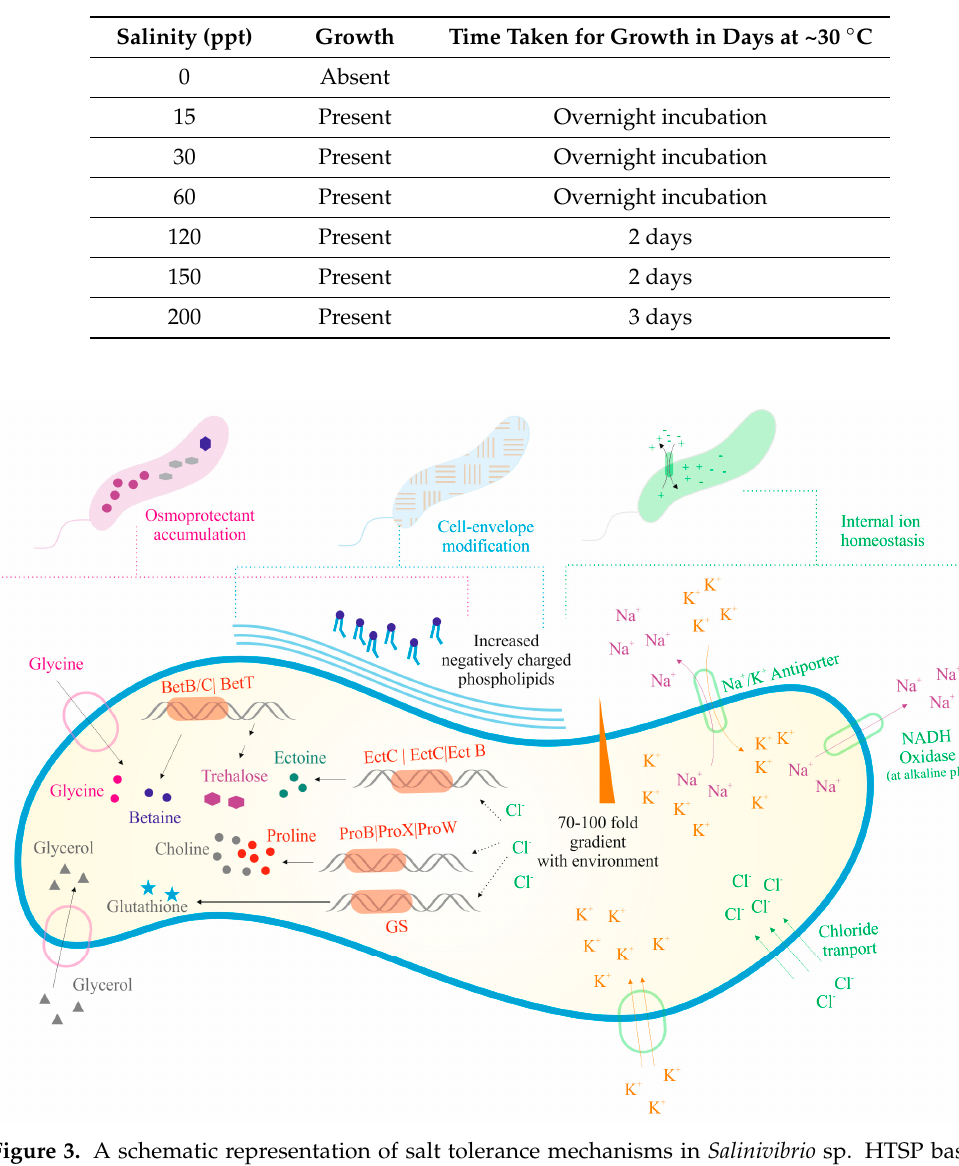
Table 2. Salinity tolerance of Salinivibrio sp. HTSP Salinity (ppt)